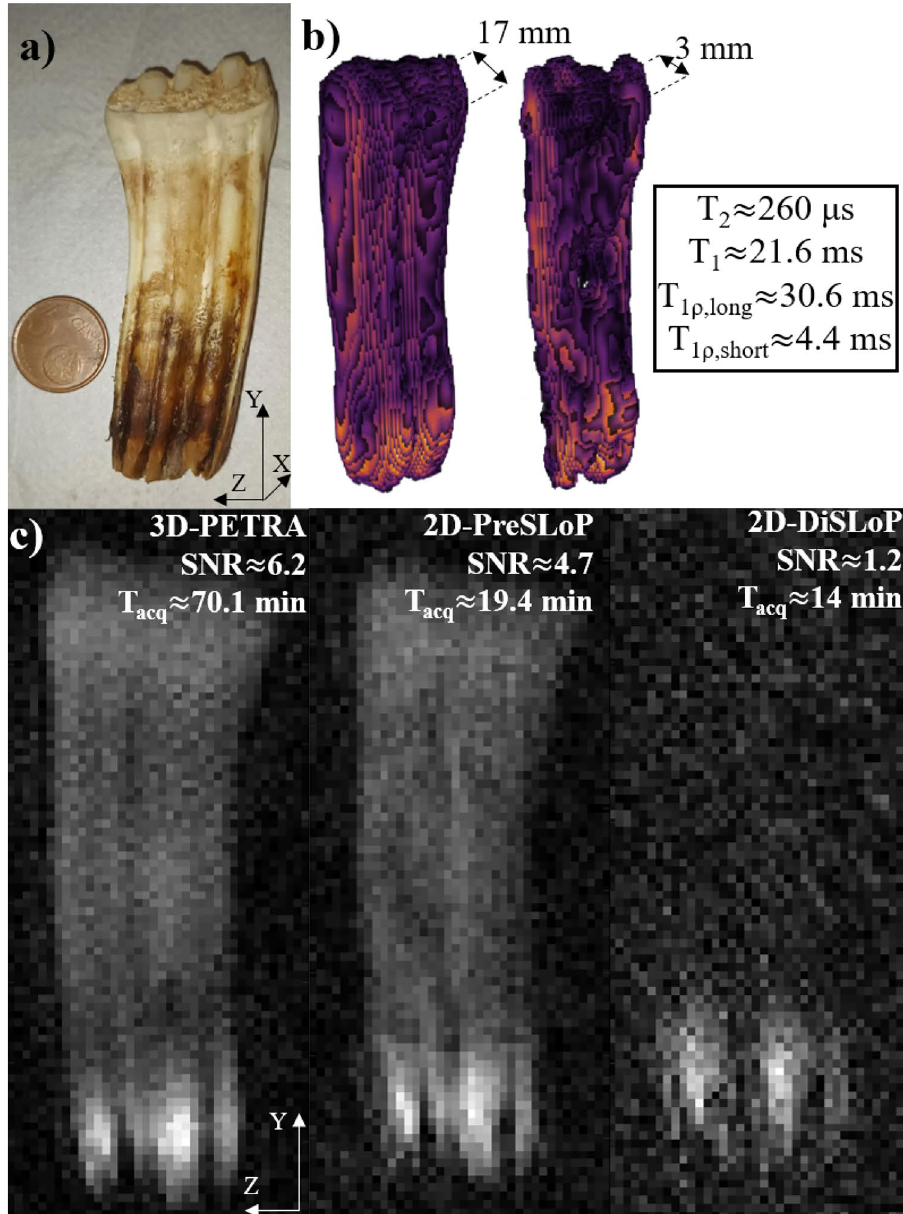
Figure 5. Performance of DiSLoP and PreSLoP for an ultra-short T 2 biological tissue (horse tooth). ( a ) Photograph of the sample. ( b ) 3D-PETRA (left) and 3D-PreSLoP (right). ( c ) 2D images for PETRA (left) with slice resolution ≈ 3 mm, PreSLoP (middle) and DiSLoP (right) with (cid:31) z ≈ 3 mm. We provide T 1 ρ for both tissues, and the average T 1 and T 2 values (see Table